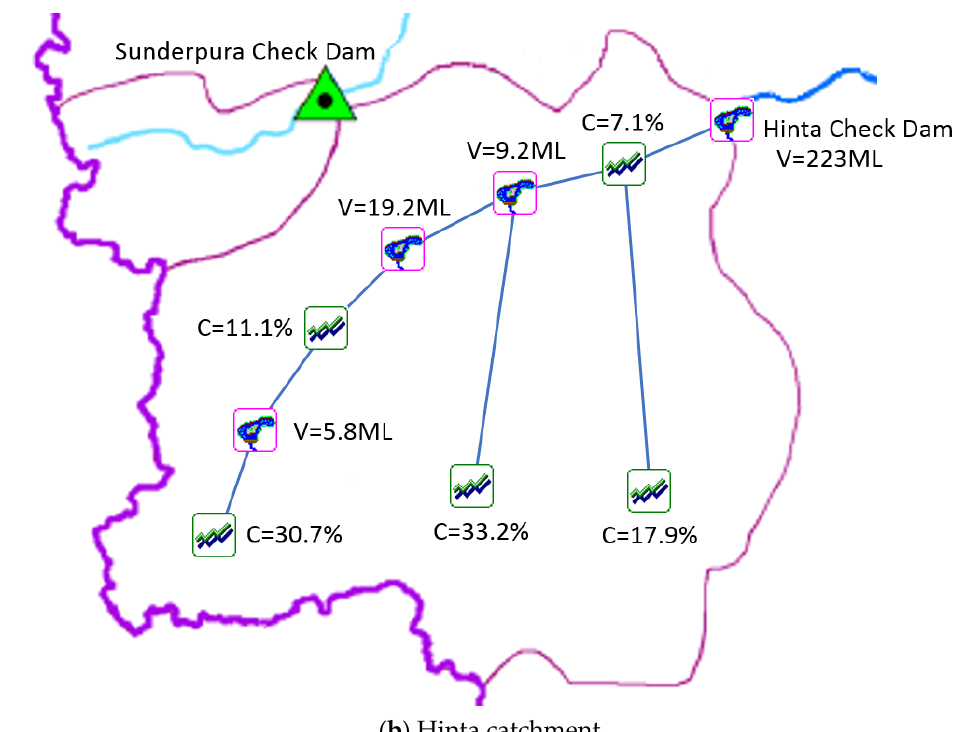
Figure 4. WaterCress schematic representing the existing upstream check dams in the ( a ) Dharta and ( b ) Hinta catchments. Nodes labelled “V” are check dams with volume in ML, and their contributing catchments are labelled “C” showing the percentage of the total catchment area of the downstream check dam.